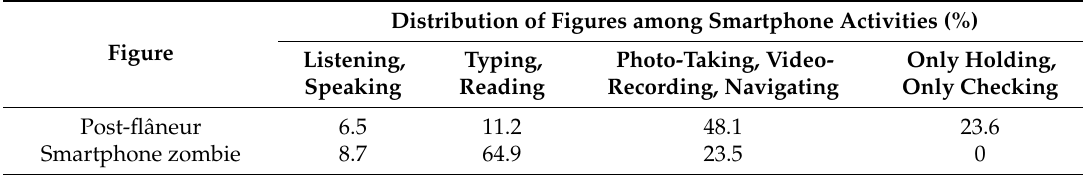
Table 5. Distribution of figures among smartphone activities. Distribution of Figures among Smartphone Activities (%) Figure Listening, Typing, Photo-Taking, Video- Only Holding, Speaking Reading Recording, Navigating Only Checking Post-fl â neur 6.5 11.2 48.1 23.6 Smartphone zombie 8.7 64.9 23.5